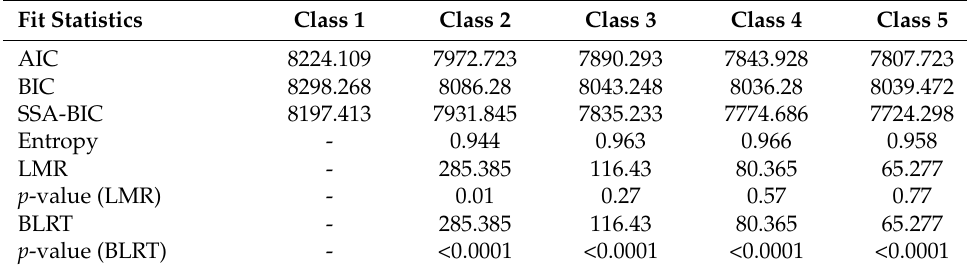
Table 5. Model fit statistics for latent class analysis (LCA).